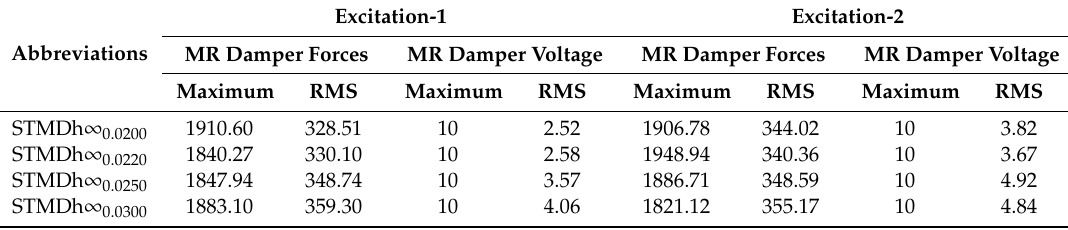
Figure 11. The maximum displacement (left-top), maximum acceleration (left-bottom), displacement RMS (right-top), and acceleration RMS (right-bottom) values of all floors under the Excitation-2 force. Force and voltage curves of the MR damper are shown in Figure 12 for the STMDh ∞ 0.0300 and values for all cases are shown in Table 2. It is seen that the maximum values are close to each other, and RMS values increase with increasing mass ratio. Table 2. The MR damper force and voltage values.